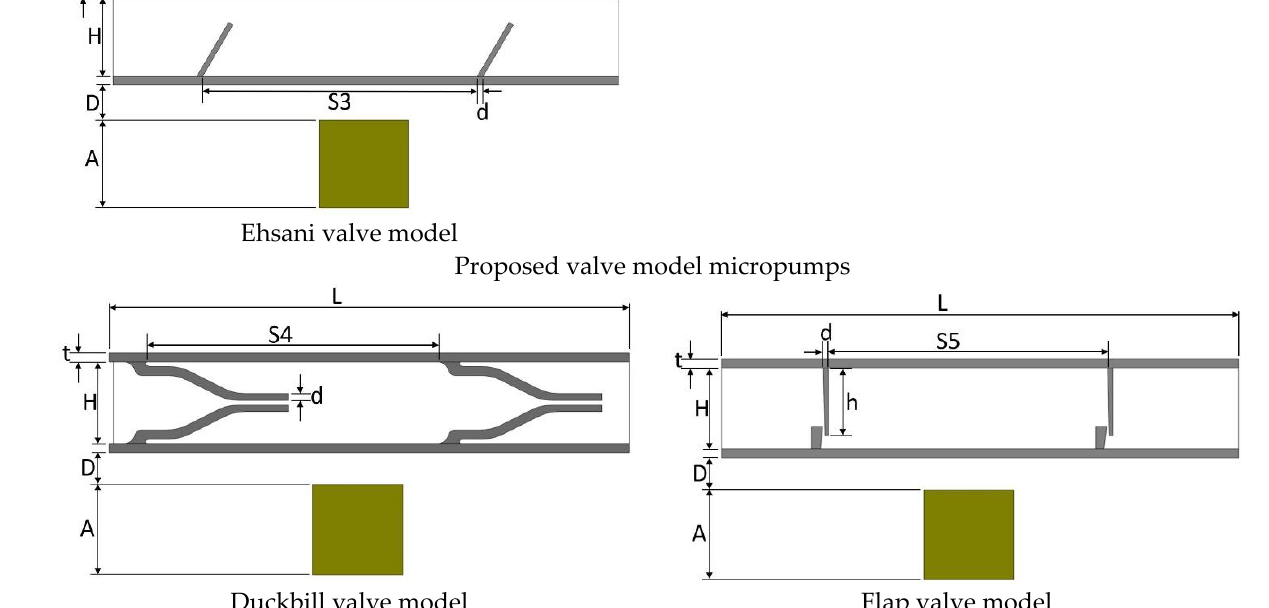
Figure 3. Valve models. Dimension values are given in Table 2.